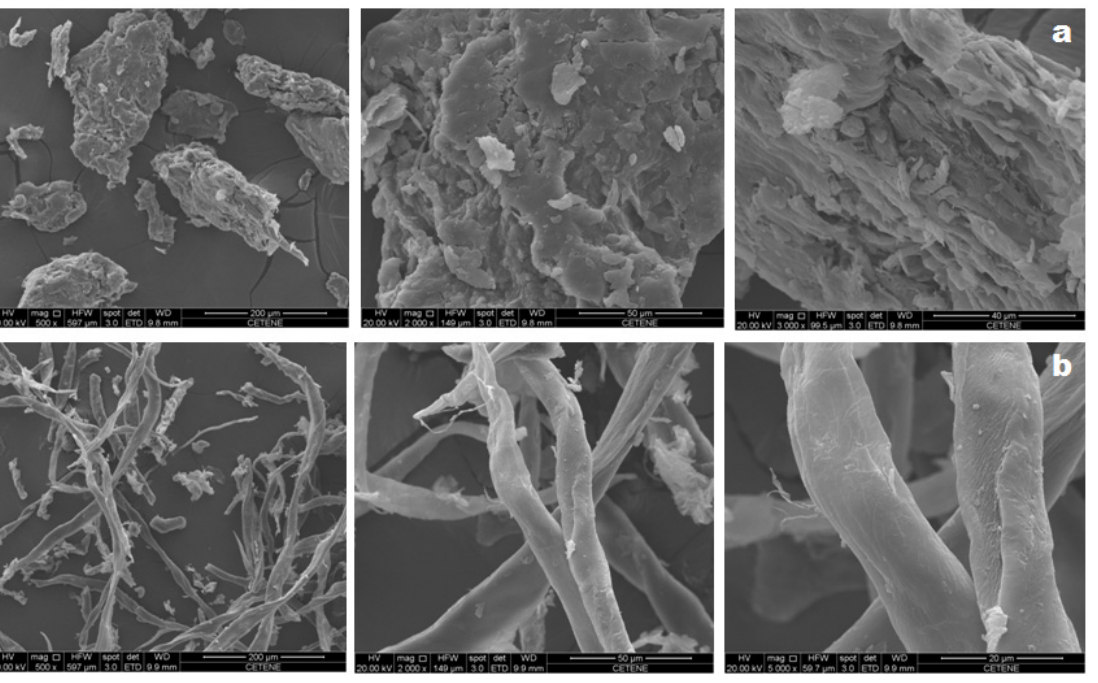
Figure 2. SEM micrographs of holocellulose ( a ) and cellulose ( b ). The magnitudes of the micrographs are 500 × , 2000 × and 5000 × , from left to right.